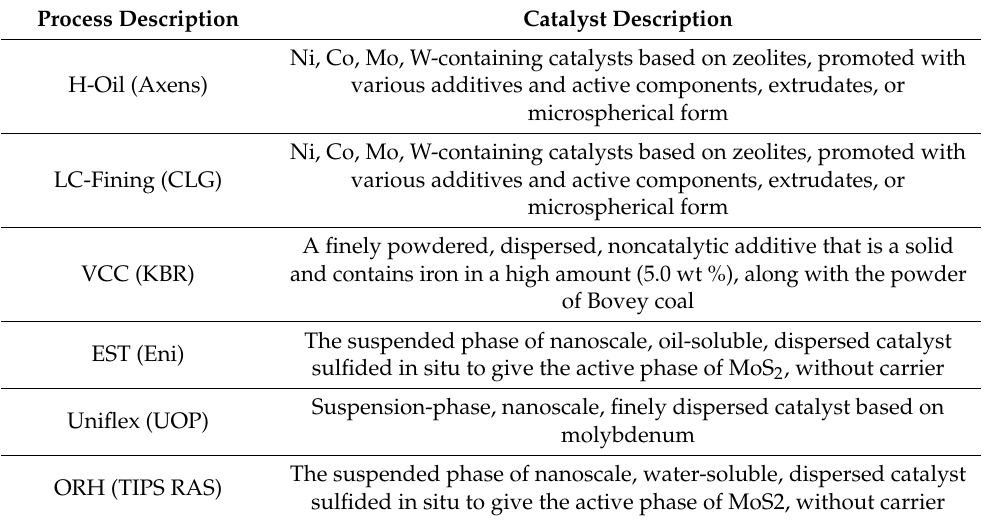
Table 7. Characteristics of the catalysts for the hydrocracking processes. Process